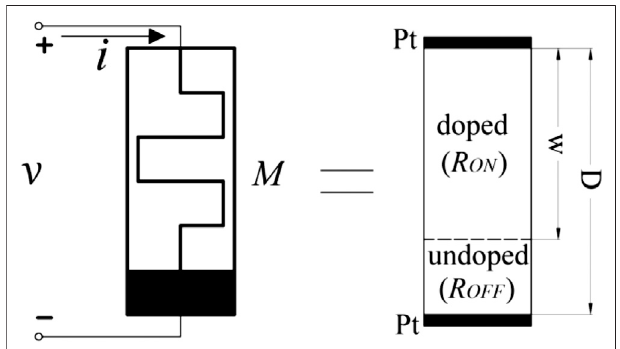
FIGURE 1 | Memristor model and